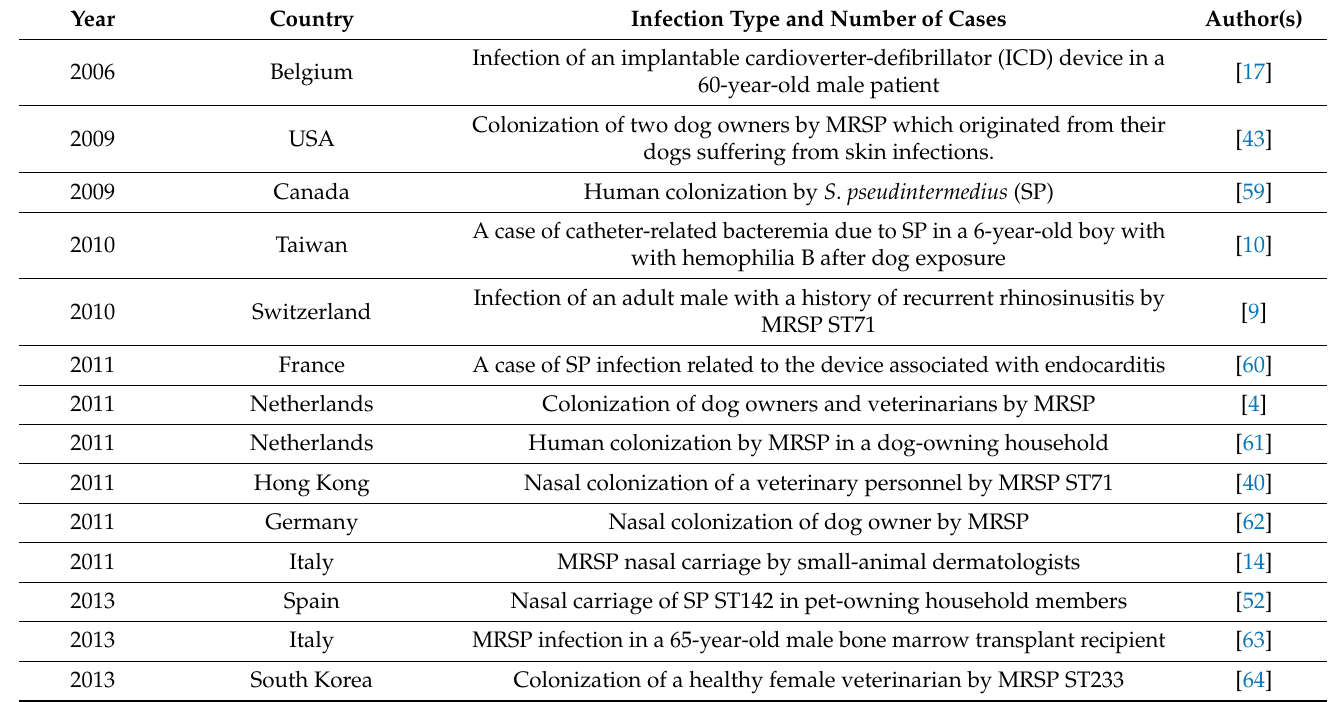
Table 2. Summary of reports on S . pseudintermedius colonization and infections in humans from